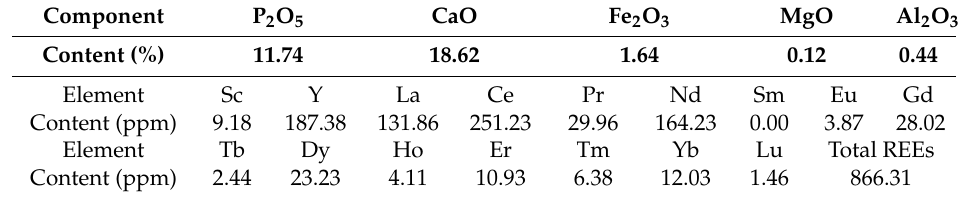
Table 2. Main chemical components and rare earths in the shaking table concentrate.